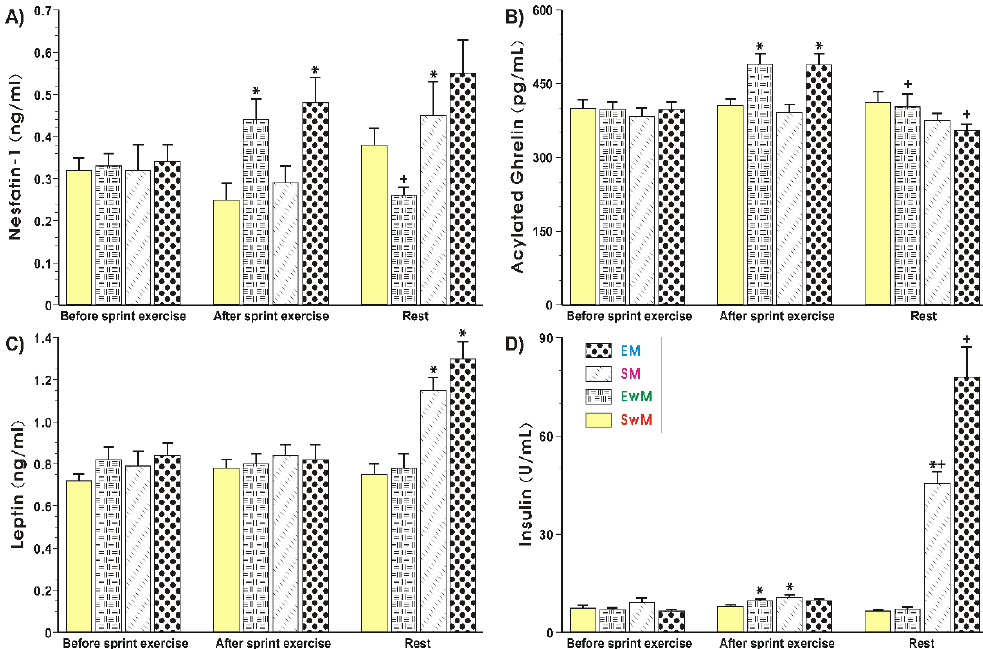
Figure 3. Plasma nesfatin-1 ( A ), acylated ghrelin ( B ), leptin ( C ) and insulin ( D ) levels determined at basal conditions and after exercise in subjects with or without meal consumption. Values represent means ±SD for 26 subjects. Statistical analysis was done by two-way repeated measures ANOVA and Tukey post hoc test. An asterisk indicates a significant change ( p < 0.05) as compared with the respective values recorded in individuals at the initiation of the test. Asterisk and cross indicate a significant increase ( p < 0.05) as compared with respective values in group SM before meal consumption and those obtained vs SwM group. Cross indicates a significant change ( p < 0.05) as compared with respective values in group EwM before and after exercise. EM—the 30 s Wingate Test (W-T30) with ad libitum test meal intake, EwM—W-T30 without ad libitum test meal intake, SM—sedentary with